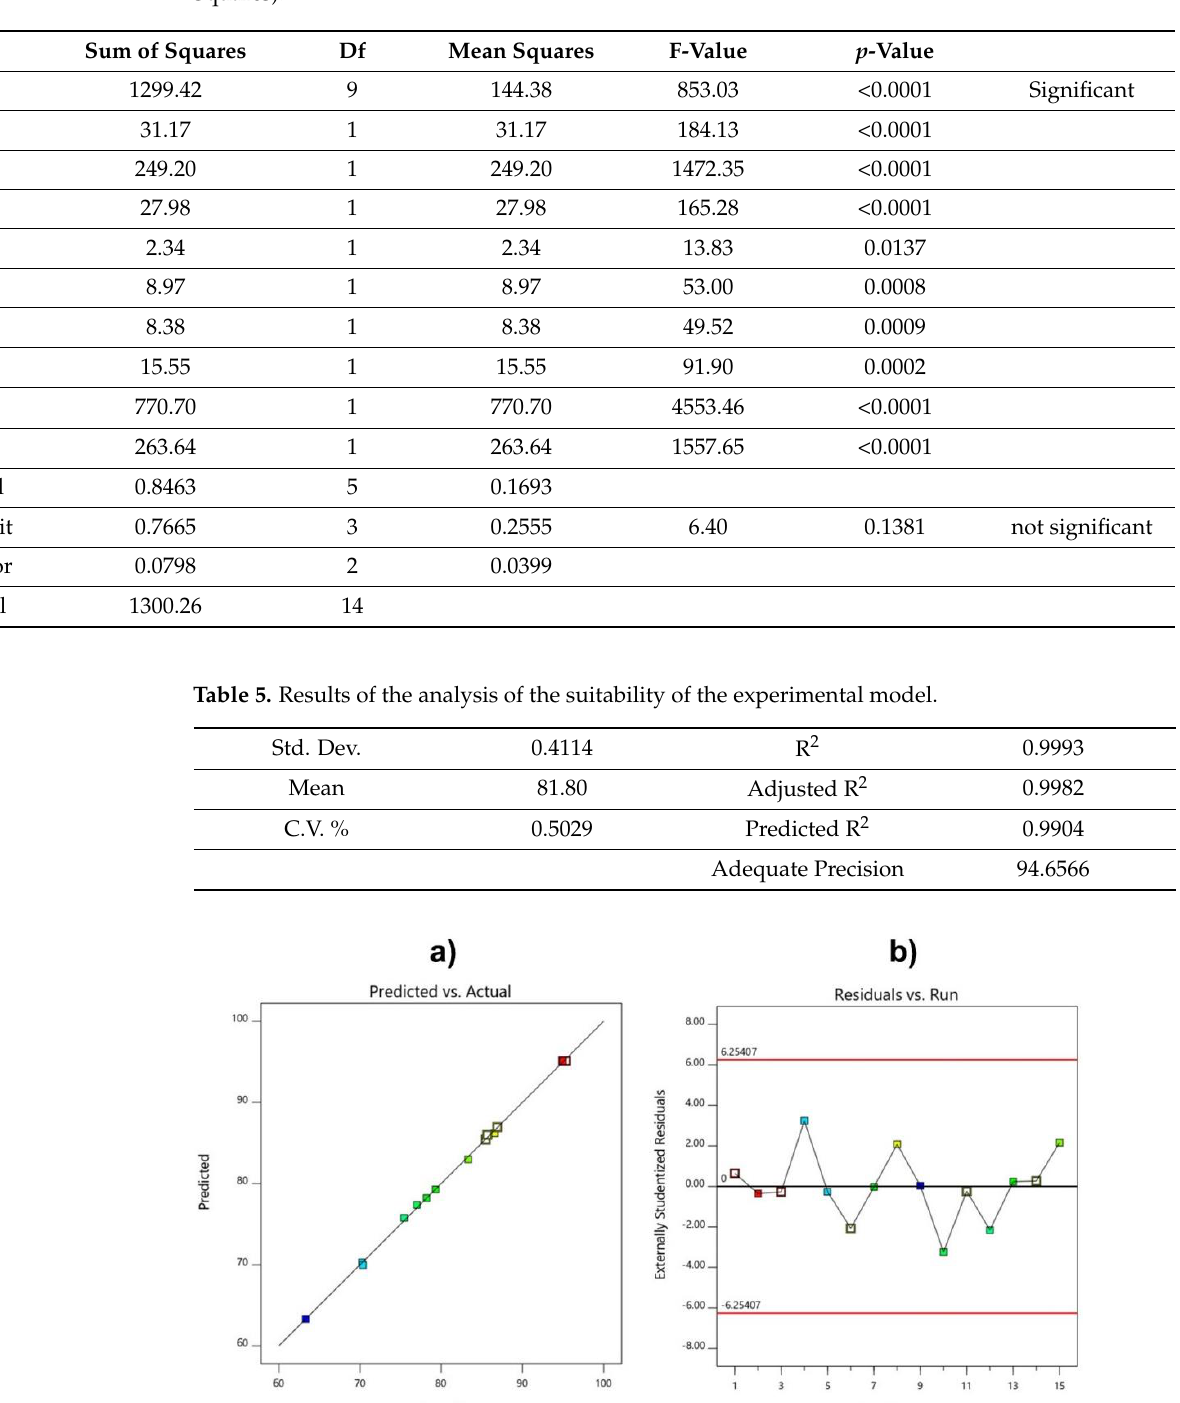
Table 4. ANOVA for the response surface quadratic model (Cor Total: Corrected Total Sum of Squares).